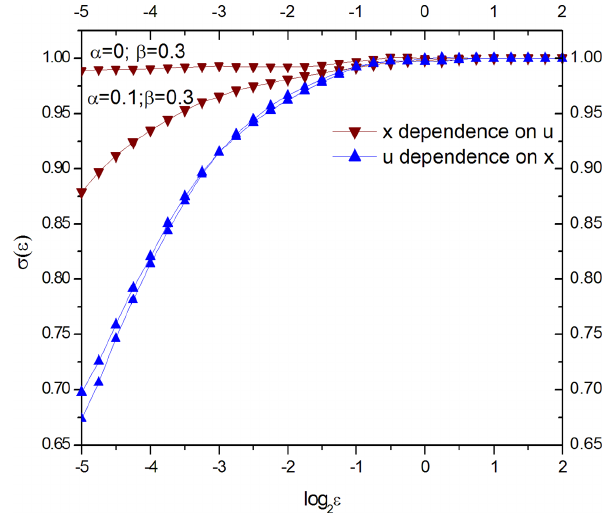
Figure 1. The conditional dispersion of coupled dynamical vari- ables u and x as described by Eqs. (2)–(3). When the connection is one directional ( α = 0, β = 0 . 3), i.e., x is the cause of u but is inde- pendent of u , the conditional dispersion of the x variable does not depend on ε , but conditional dispersion of the u variable declines for diminishing ε . When the connection is two directional ( α = 0 . 1, β = 0 . 3), the conditional dispersion of both variables declines for smaller ε , but the x variable, which provides a stronger causal force, has a dispersion with weaker